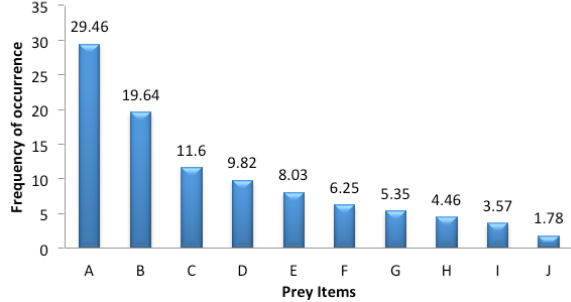
Figure 2. Overall visualisation of the scat contents in Common Palm Civet diet in PBS. A—Insects | B—Fruit of Ficus religiosa | C—Fruit